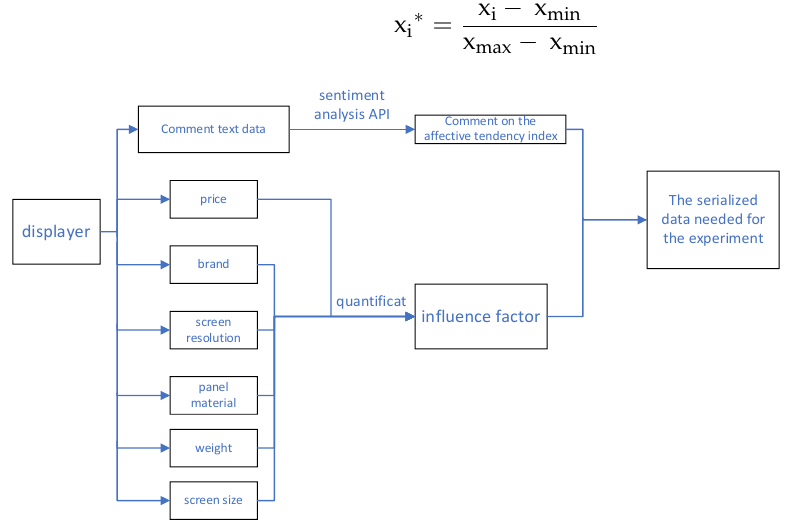
Figure 10. Flowchart of the transformation of raw data into serialized data.